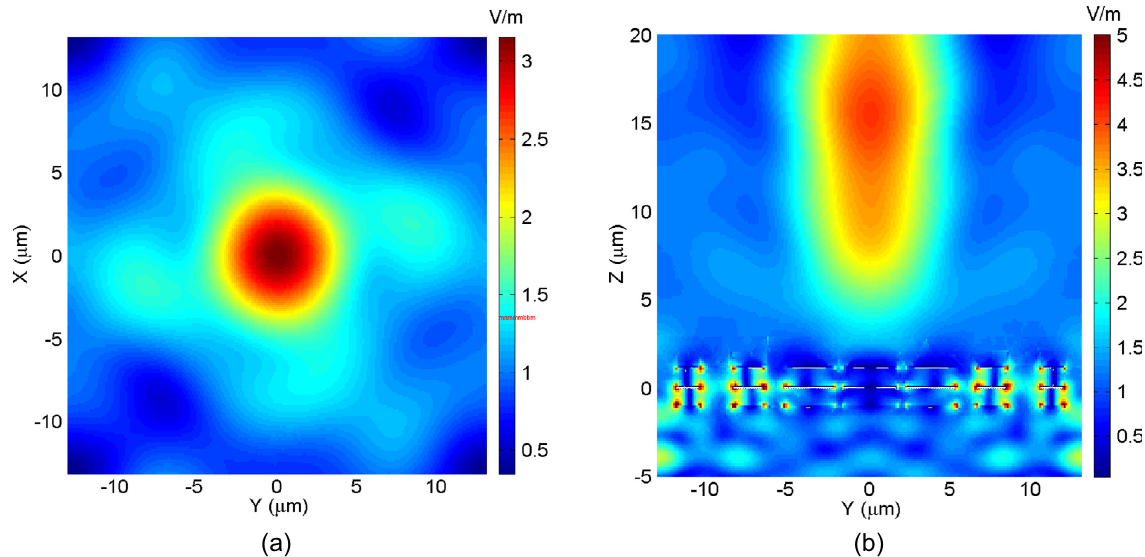
p V/m. (a) Complex magnitude of E-field on the X - Y plane, (b) complex magnitude of